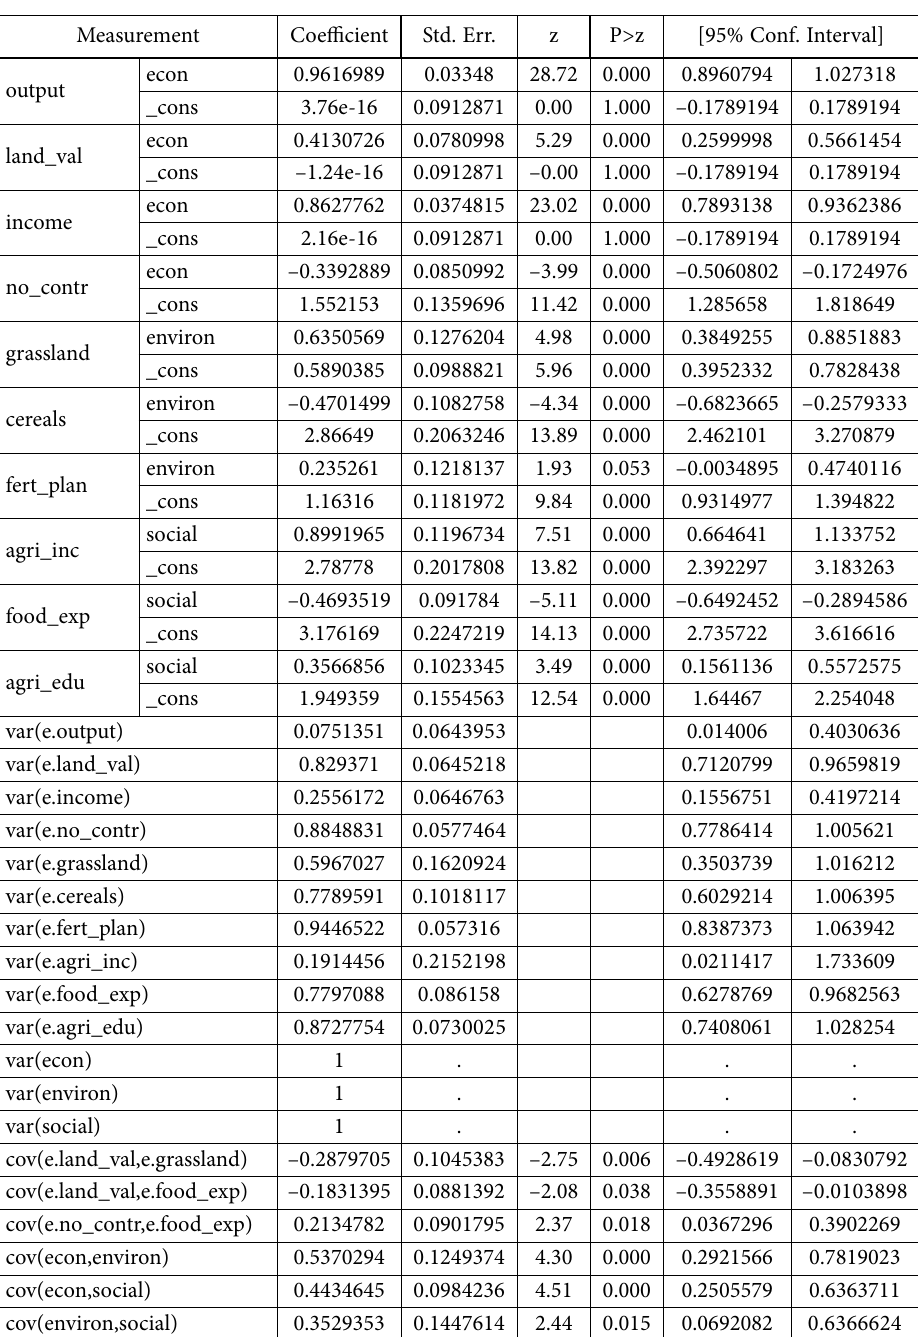
Table 3. Results of structural equation modeling using multiple-factor measurement